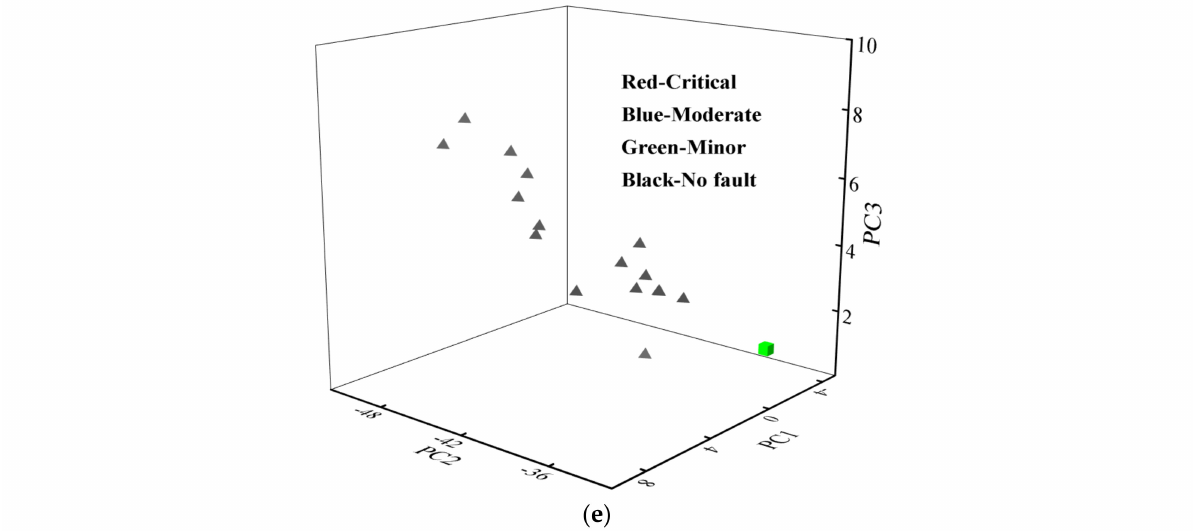
Figure 7. Fault grading performance based on mRVM: ( a ) Overview; ( b ) Critical fault; ( c ) Moderate fault; ( d ) Minor fault; ( e ) Healthy.